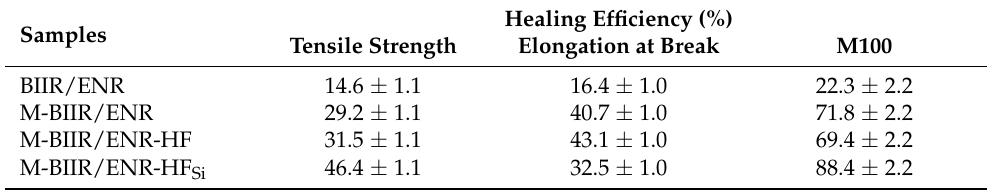
Table 5. Healing efficiency based on tensile properties, elongation at break and M100.